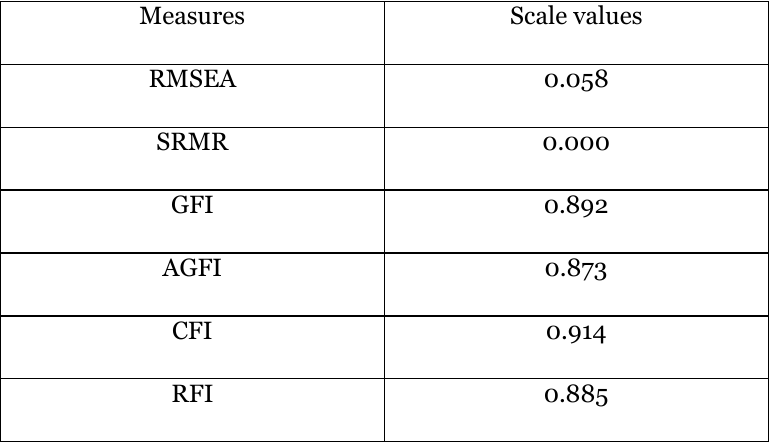
Table 7 The Fit Values of Self-regulation Skills